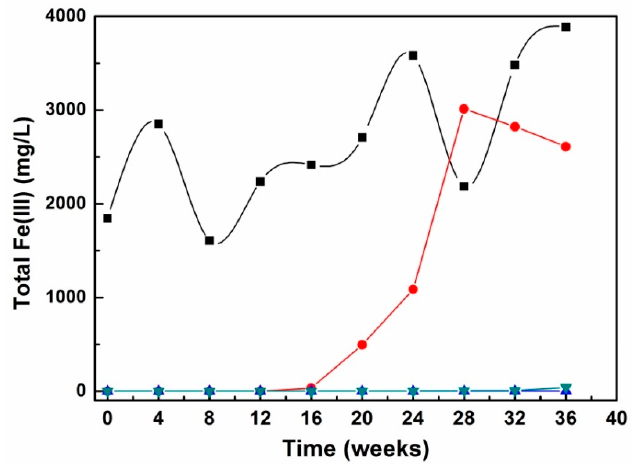
Figure 5. The concentration of total ferric iron in leachates from KLC tests using the natural mine wastes. See Figure 4a for legend.